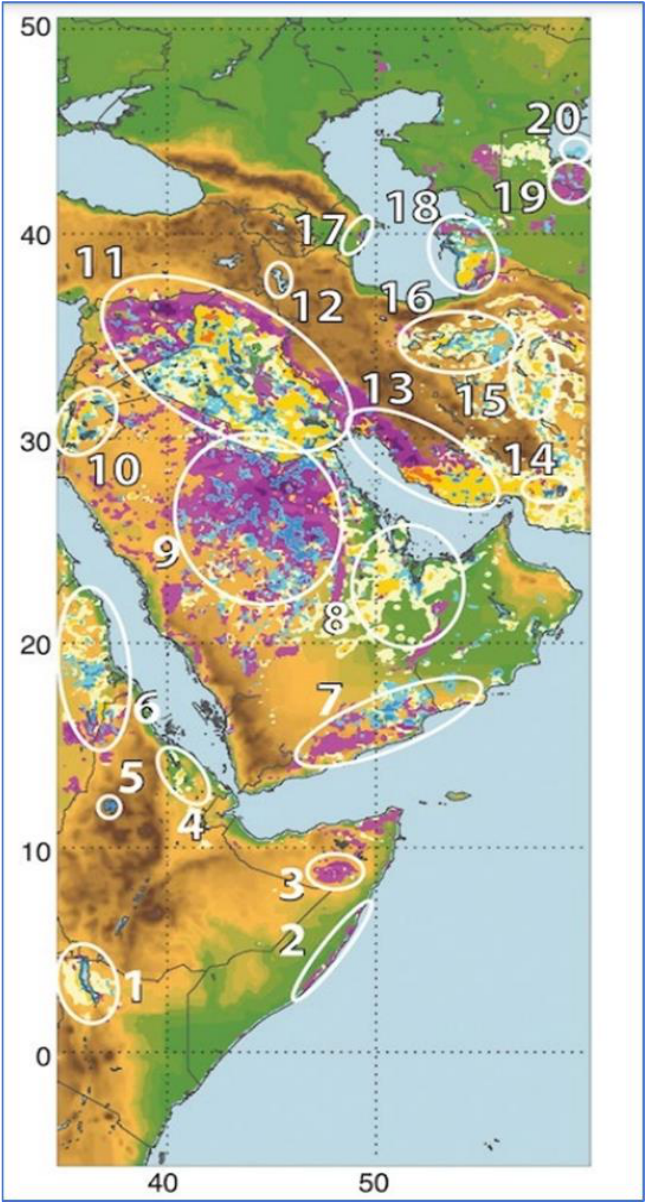
Figure 12. Distribution of day/year (%), with dust optical depth > 0.2 over the ME [53].